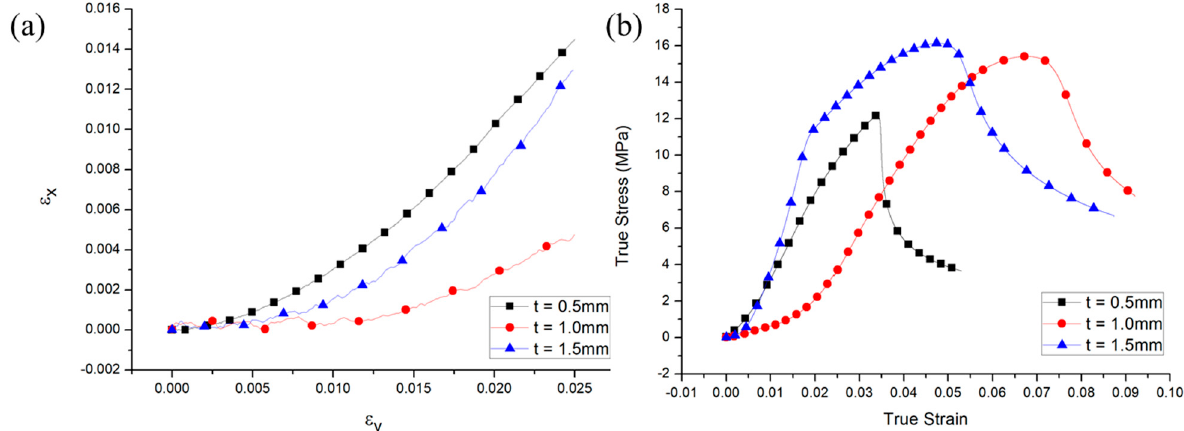
Figure 6. The Poisson’s ratio ε x- ε y curve and stress-strain curve of MA auxetic structure of different pillar thickness. ( a ) ε x - ε y curve ( b ) Stress-strain curve.